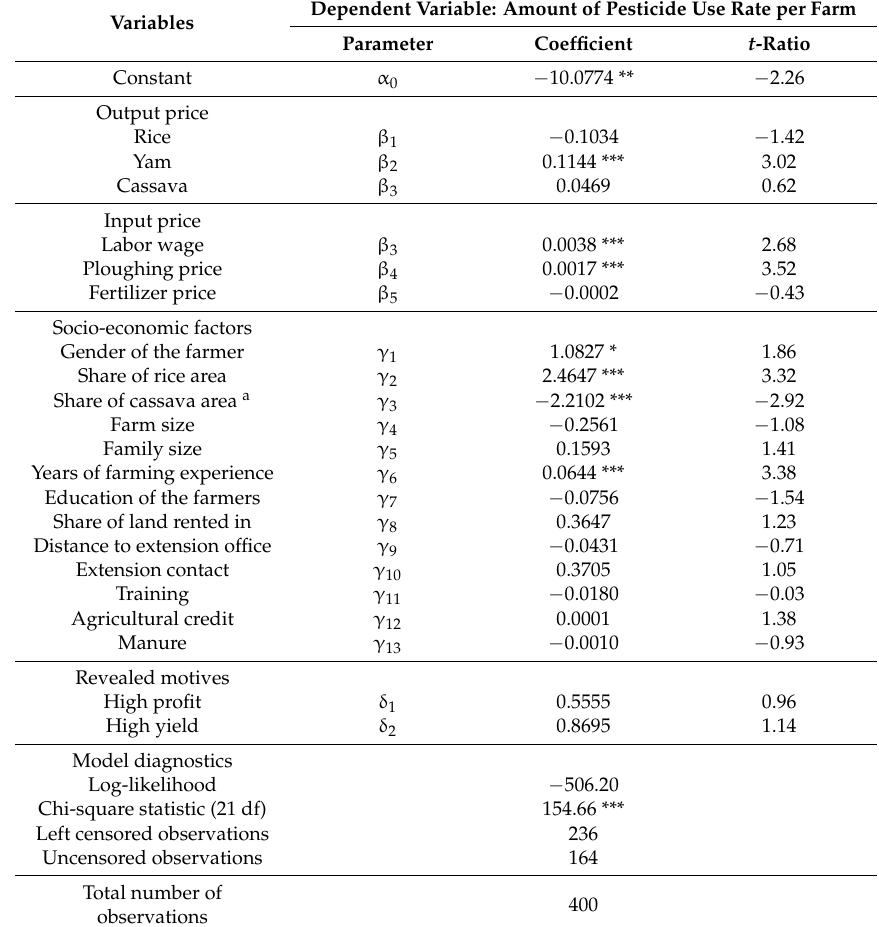
Table 6. Determinants of pesticide use in producing food